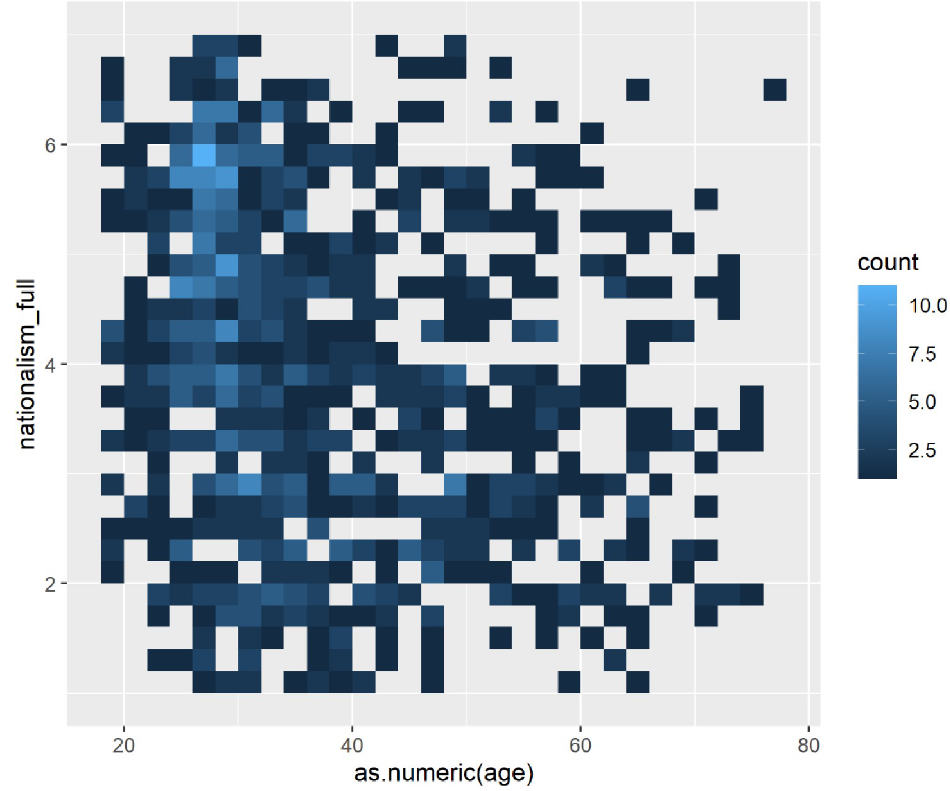
Fig 9. Heatmap of nationalism by age for